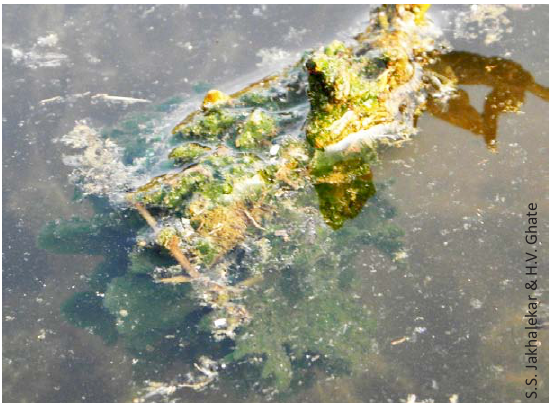
Image 5. Radiospongilla cerebellata attached to a submerged plant